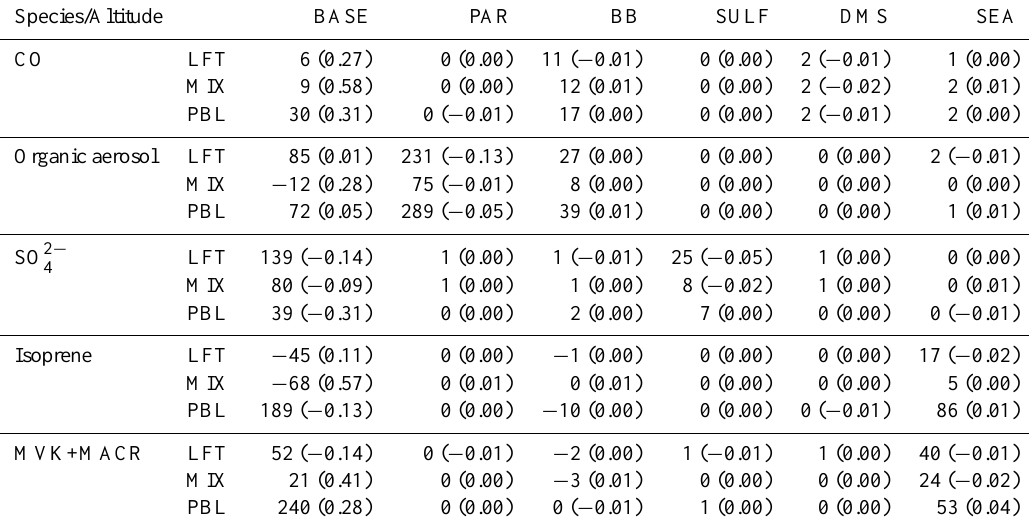
Table 7. Mean percentage bias, model minus data, and Pearson correlation coefficient (in brackets) between the ACES/OP3 aircraft data and the GEOS-Chem global 3-D chemistry transport model that has been sampled at the time and location of the data for the BASE run. The sensitivity runs PAR, BB, SULF, DMS, and SEA (described in Sect. 4) are expressed as the percentage change relative to BASE, with the correlation coefficient change relative to the BASE case (in bracket). PBL, MIX, and LFT are defined as pressure P > 915 hPa, 915 hPa >P > 740 hPa, and P < 740 hPa, respectively, following Robinson et al. (2012).